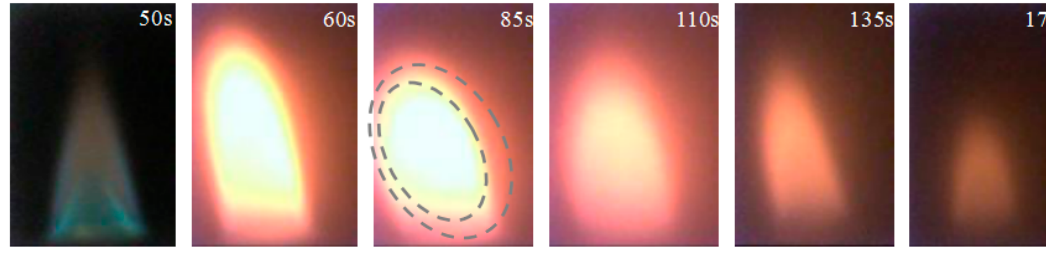
Figure 5. Fire suppression process using water mist.